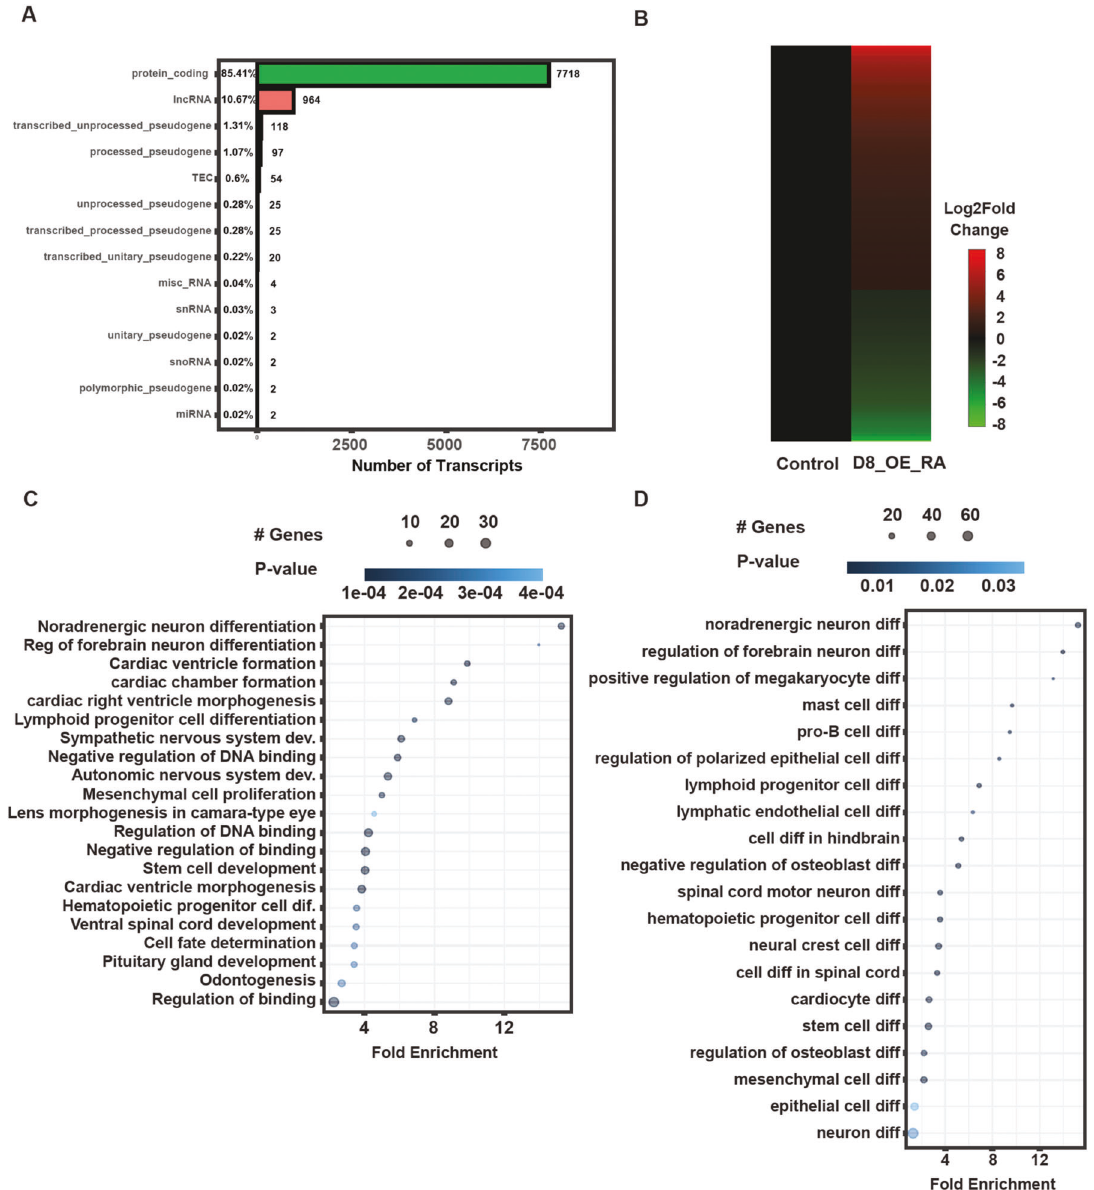
Fig. 3 ZMYND8 regulates key pathways of neuronal differentiation. A Biotype-based classi fi cation of ZMYND8-regulate transcripts. B Heatmap depicting differential lncRNA gene expression upon ZMYND8 overexpression with ATRA treatment. C Genomic Regions Enrichment of Annotations Tool (GREAT) analysis of ZMYND-regulated lncRNAs. D The neuronal differentiation processes associated with ZMYND8-regulated lncRNAs as identi fi ed using